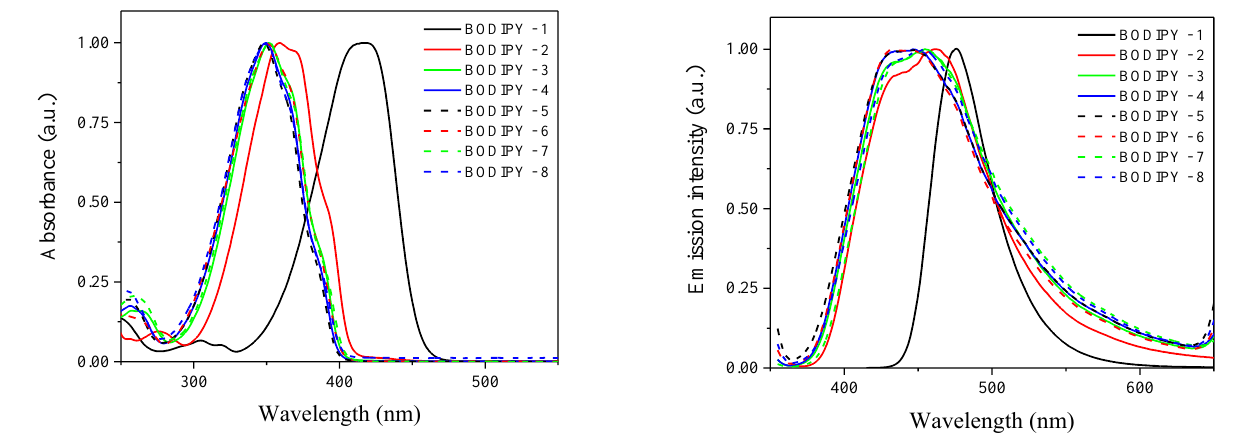
Figure 21. Normalized absorption ( L ) and fluorescence ( R ) spectra of boron dipyrromethene dyes (BODIPY-1 – BODIPY-8) registered in acetonitrile at room temperature. Reproduced from ref. [115], which was published under a CC BY license.